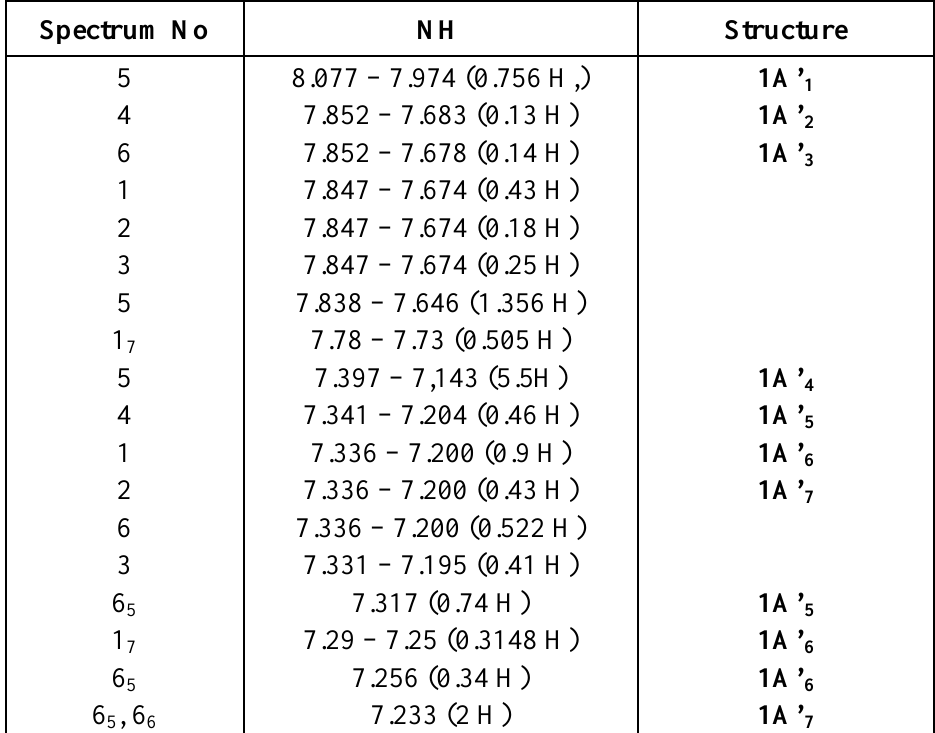
Table 11. The 1 H-NMR chemical shifts δ [ppm] from TMS of the NH group of tautomer 1A’ (in CDCl 3